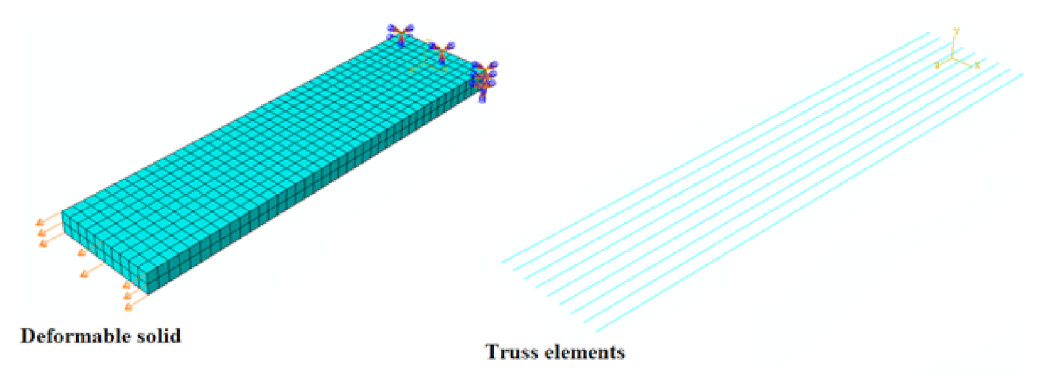
Figure 5. FRCM models.